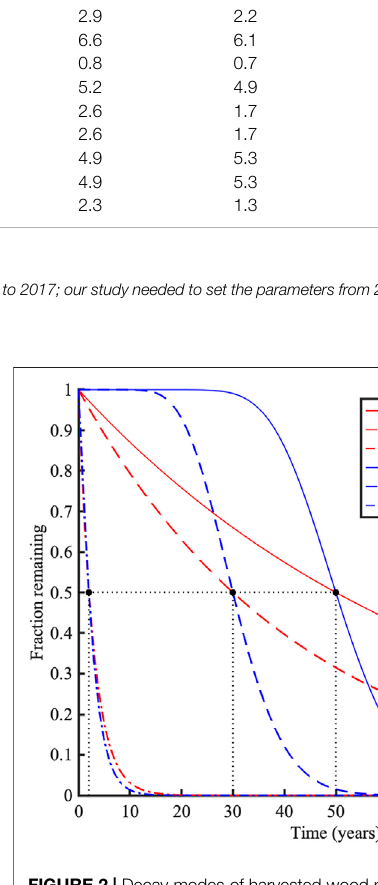
FIGURE 2 | Decay modes of harvested wood products under different